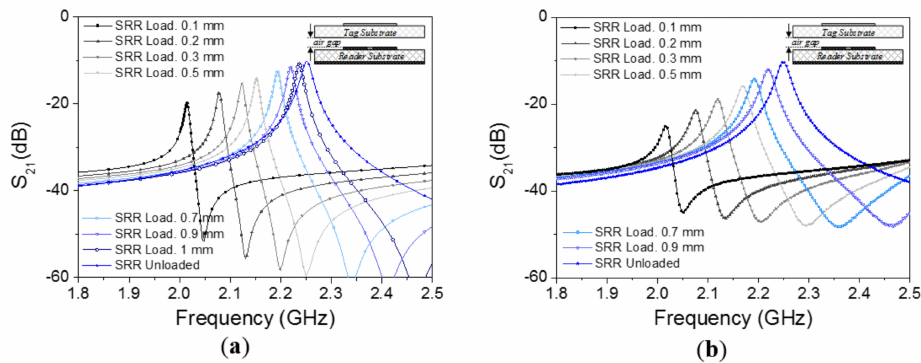
Figure 3. Frequency responses of the channel line without tag on top of it and with SRR tags (perfectly aligned) at different distances. The considered configuration is the one of Figure 2c; ( a ) electromagnetic simulation; ( b ) measurement. The dimensions are: W 1 = 0.58 mm, W 2 = 0.87 mm, l 1 = 5.53 mm, l 2 = 5.86 mm, s 1 = 0.35 mm, s 2 = 0.2 mm. The considered tag substrate has a dielectric constant of ε r = 10.2 and a thickness of h = 0.63 mm.